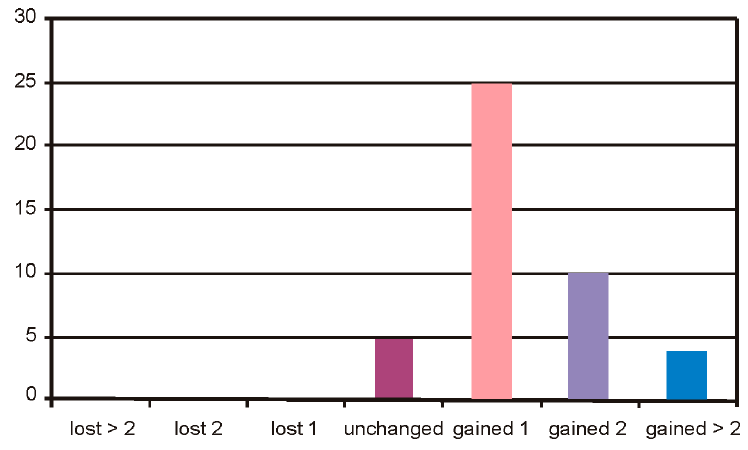
Figure 10. Treatment safety of Group 1.